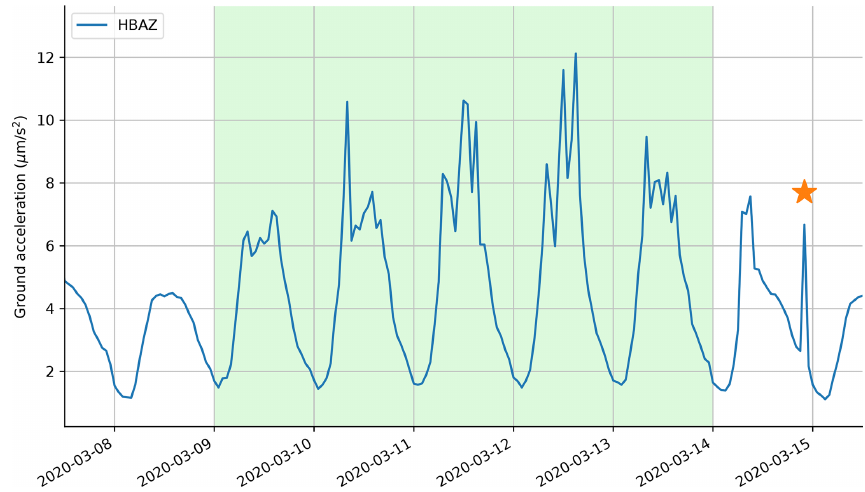
Figure 3. Standard deviation over 30min intervals of the ground acceleration of short-period borehole station HBAZ. Times are in local NZT, and weekdays have a green background. Note the lower nighttime noise level compared to daytime, and quieter weekends. The origin time of the Kermadec Islands region event ID us60008fl8 is annotated with a star.